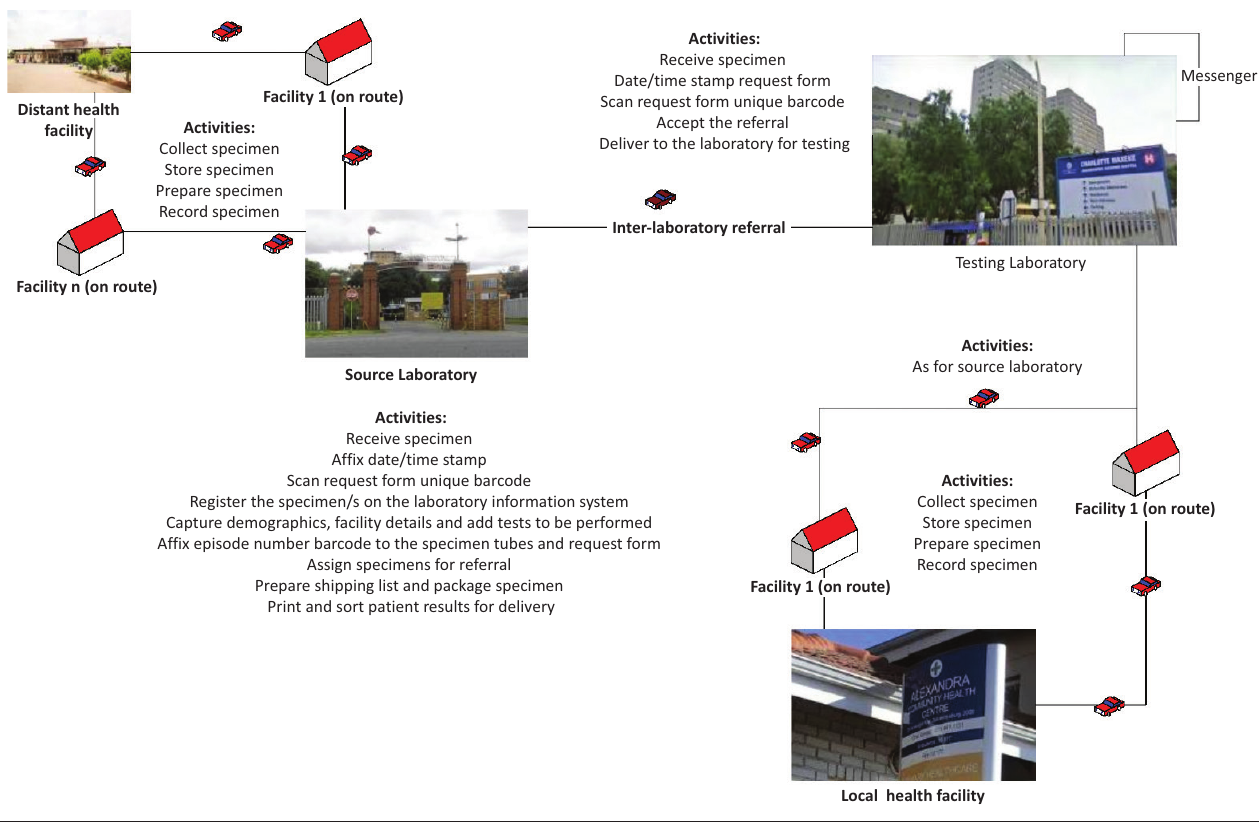
FIGURE 1: Sources of specimens and activities performed at the Charlotte Maxeke Johannesburg Academic Hospital laboratory receiving office, South Africa, April 2019 – March